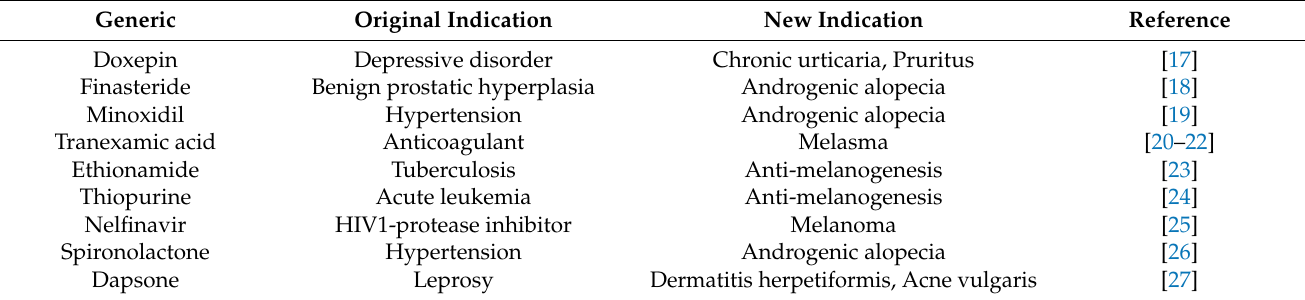
Table 1. Examples of drug repositioning in